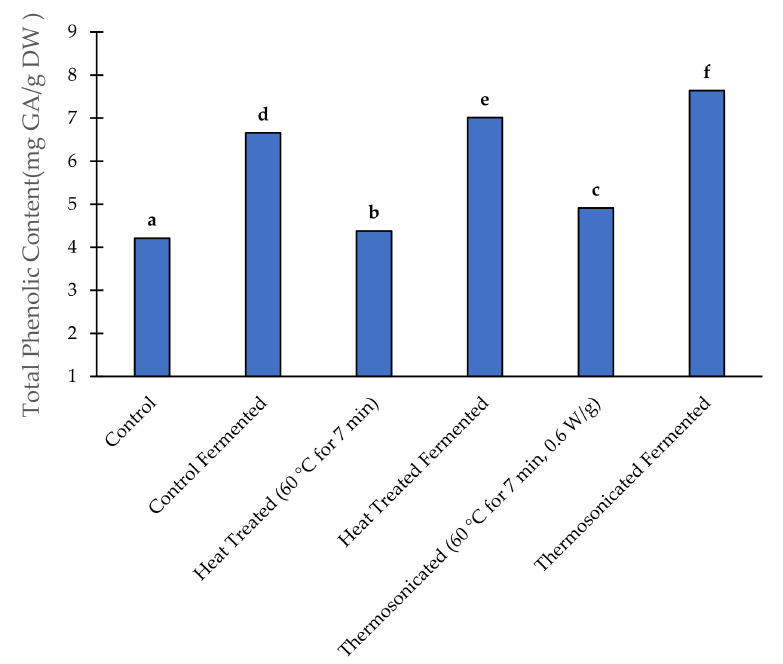
Figure 2. The changes in the total phenolic content of broccoli purees made from thermally or thermosonication-treated broccoli florets before and after lactic acid fermentation. ‘Control’ denotes non-pre-treated broccoli puree. Different lowercase letters (a–f) over the bars denote significant differences ( p <